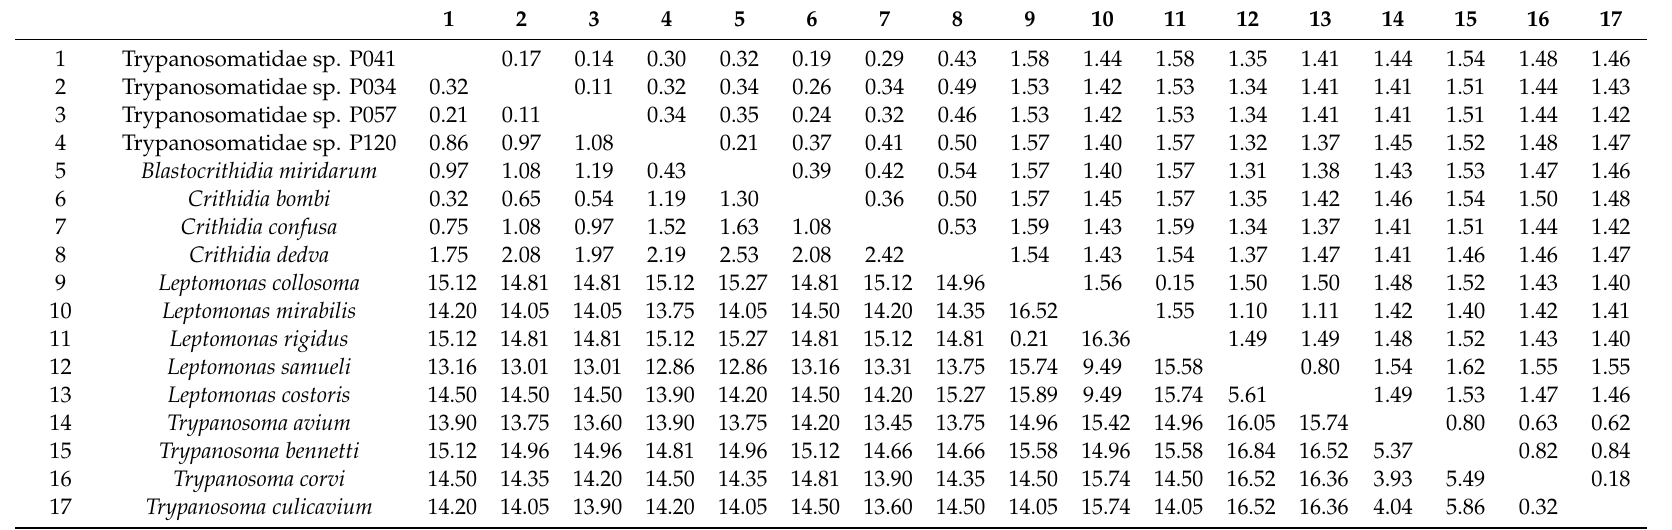
Table 2. Estimates of evolutionary divergence comparing sequences obtained from Philornis downsi and known GenBank reference sequences. Partial sequences from the conserved region of the 18S rRNA gene were analyzed. Percent di ff erences of base substitutions between sequences are shown below the diagonal. Standard error estimates are shown above the diagonal. Analyses were conducted using the Jukes–Cantor model [55]. The rate variation among sites was modeled with a gamma distribution (shape parameter = 1). The analysis involved 17 nucleotide sequences. All positions with less than 95% site coverage were eliminated. That is, fewer than 5% alignment gaps, missing data, and ambiguous bases were allowed at any position. There were a total of 938 positions in the final dataset. Evolutionary analyses were conducted in MEGA6 [49]. All GenBank accession numbers and strain / isolate names can be found in Table